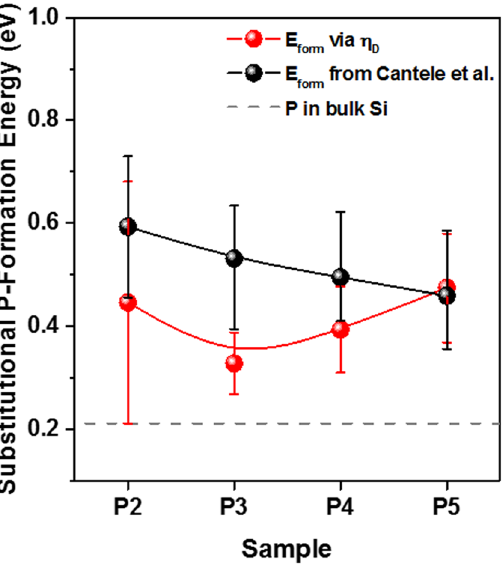
Figure 6. Formation energies of substitutional P-atoms in Si NCs. The results from Equation (4) using the doping efficiency are shown in red. The formation energies calculated using the results presented in ref. 44, i.e., = . + . . E d 0 21008 4 98131/(0 5 ) with energies in units of eV and NC-radii in Å, are shown in black. The form NC grey dashed line represents the bulk formation energy 44 . The solid lines (splines) are just a guide to the